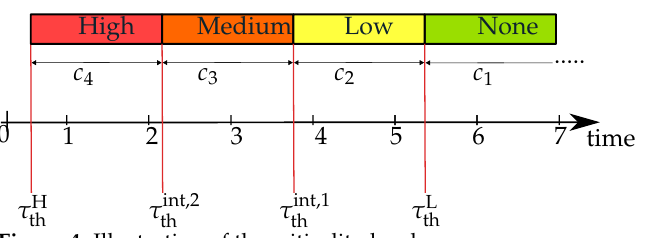
Figure 4. Illustration of the criticality